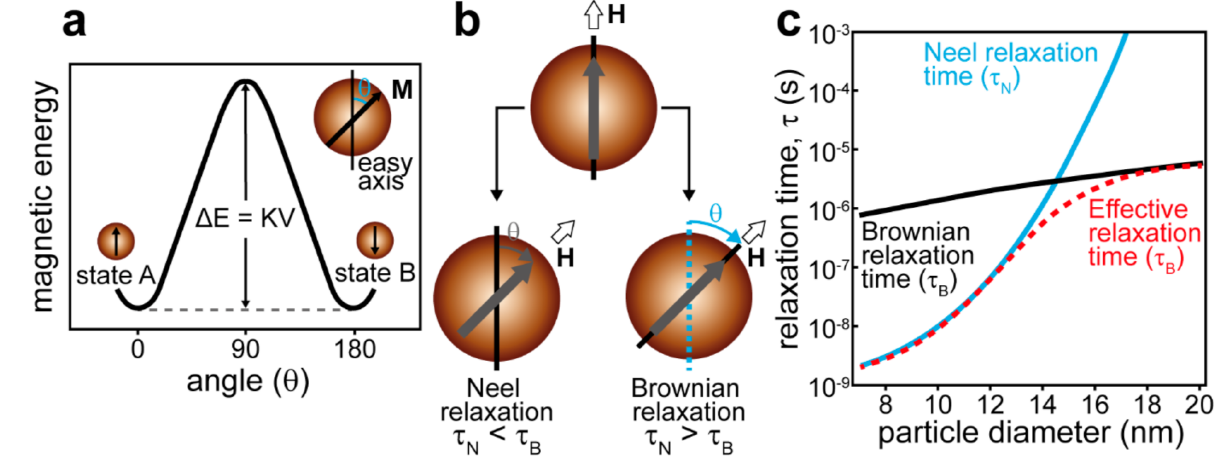
Figure 4. ( a ) The magnetic anisotropy energy barrier ( ∆ E) as a function of the angle between the easy axis and the magnetization orientation in a single magnetic domain regime. ( b ) Schematic presentation of the magnetic loss from MNPs through Neel and Brownian relaxation. (i) Neel relaxation: magnetic spins rotate while the particles remain fixed. (ii) Brownian relaxation: magnetic spins remain fixed along the crystalline axis while the particles physically rotate. ( c ) Relaxation times as a function of the particle diameter for single-domain magnetite MNPs. The relaxation times are given by Equations (1)–(3). Adapted with permission from [111]. Copyright 2017, Elsevier